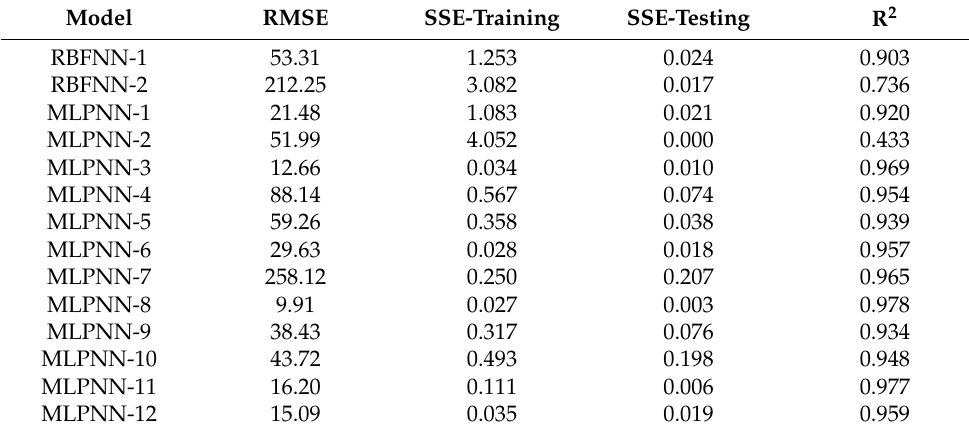
Table 3. Summary of performance analysis for the